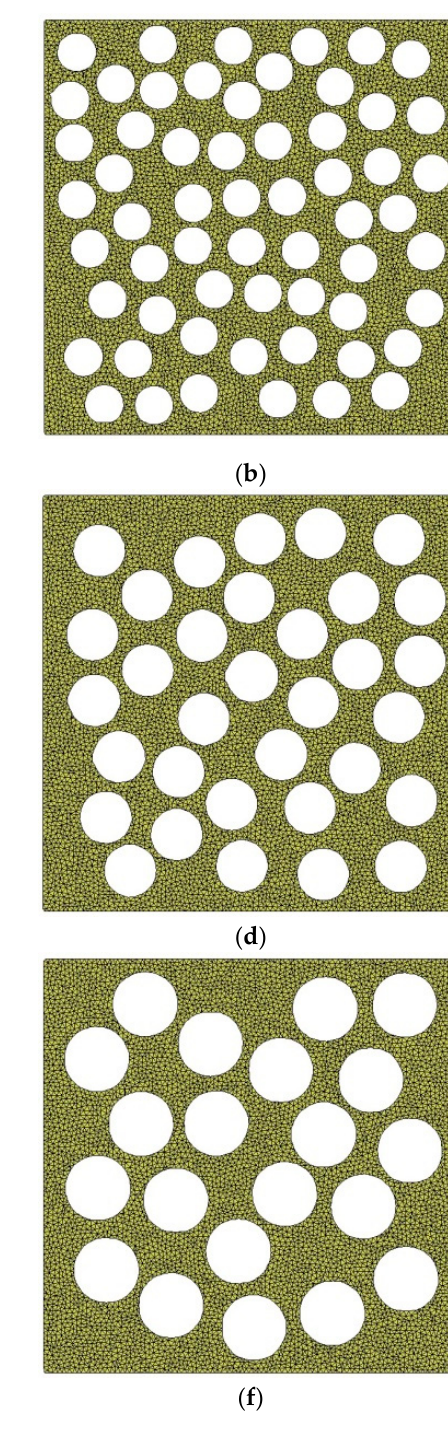
Figure 7. Models with different pore equivalent diameters: ( a ) EqD = 0.10 mm; ( b ) EqD = 0.12 mm; ( c ) EqD = 0.14 mm; ( d ) EqD = 0.16 mm; ( e ) EqD = 0.18 mm; ( f ) EqD = 0.20 mm.